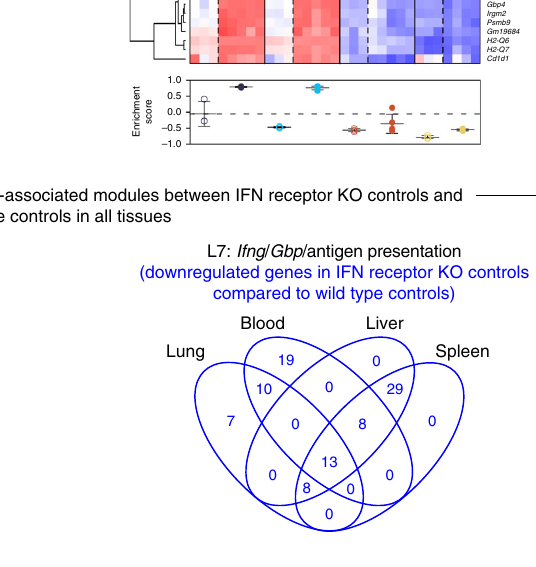
hub genes in the Type I IFN/ I fi t / Oas module (L5), across all tissues, with the greatest decrease observed in the liver and spleen upon T. gondii infection (Fig. 7). The genes in this network were abrogated in the absence of IFN- γ signaling during T. gondii infection in Ifngr − / − mice (Fig. 7), similarly to fi ndings reported above (Fig. 6). The biggest decrease in genes in this network